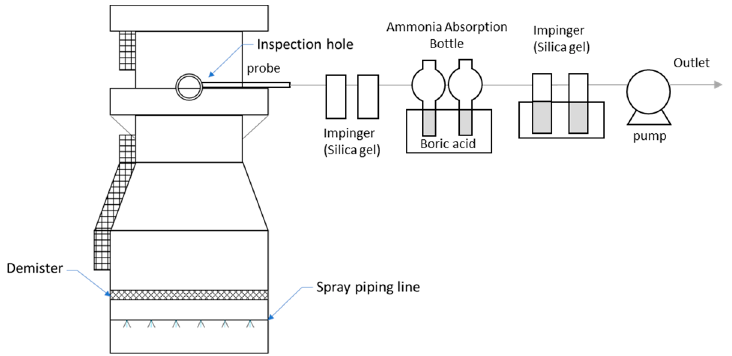
Figure 1. Schematic of the field setup for ammonia sampling at NPK fertilizer production plants.